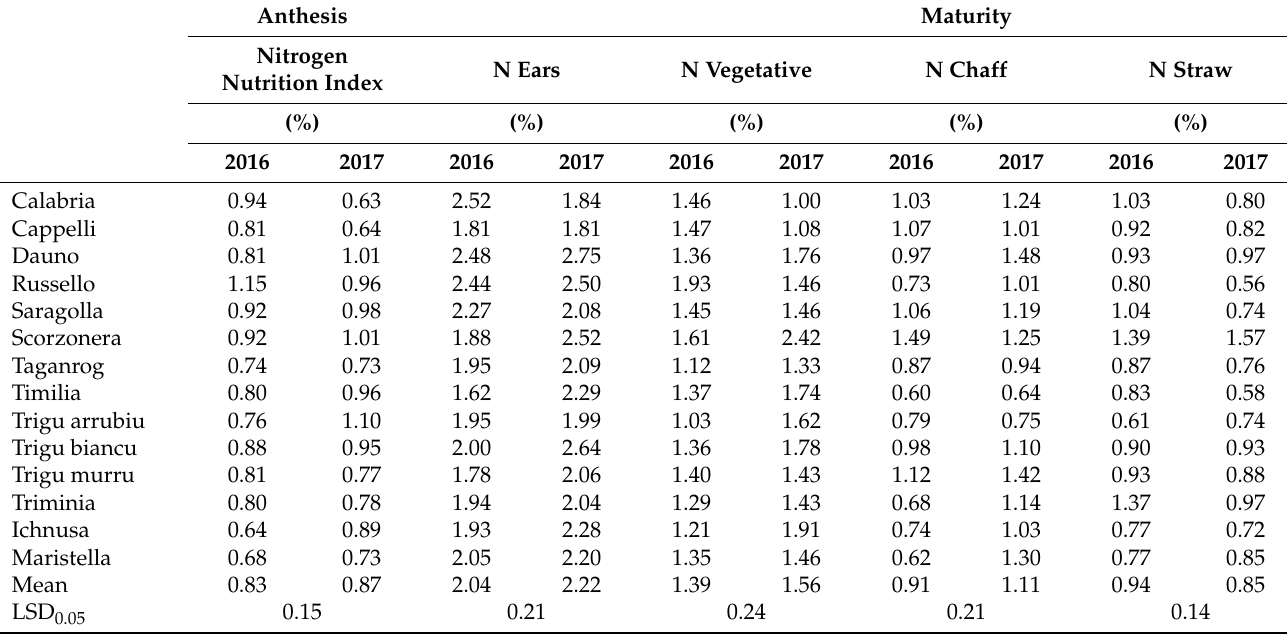
Table 5. Main nitrogen traits recorded at anthesis. LSD 0.05 for the comparison of cultivar means at the same or different levels of